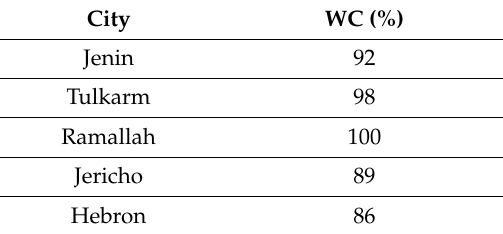
Table 15. Water coverage (WC) (year 2017).